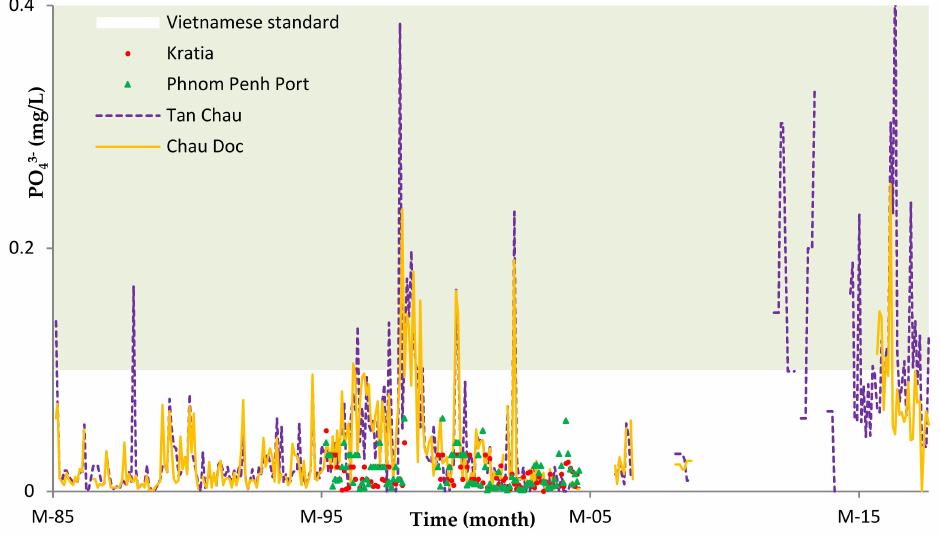
Figure 10. Temporal concentrations of PO 43 − in the Vietnamese side (Tan Chau and Chau Doc stations) from 1985 to 2017 and in the Cambodia side (Phnom Penh Port and Kratie) from 1995 to